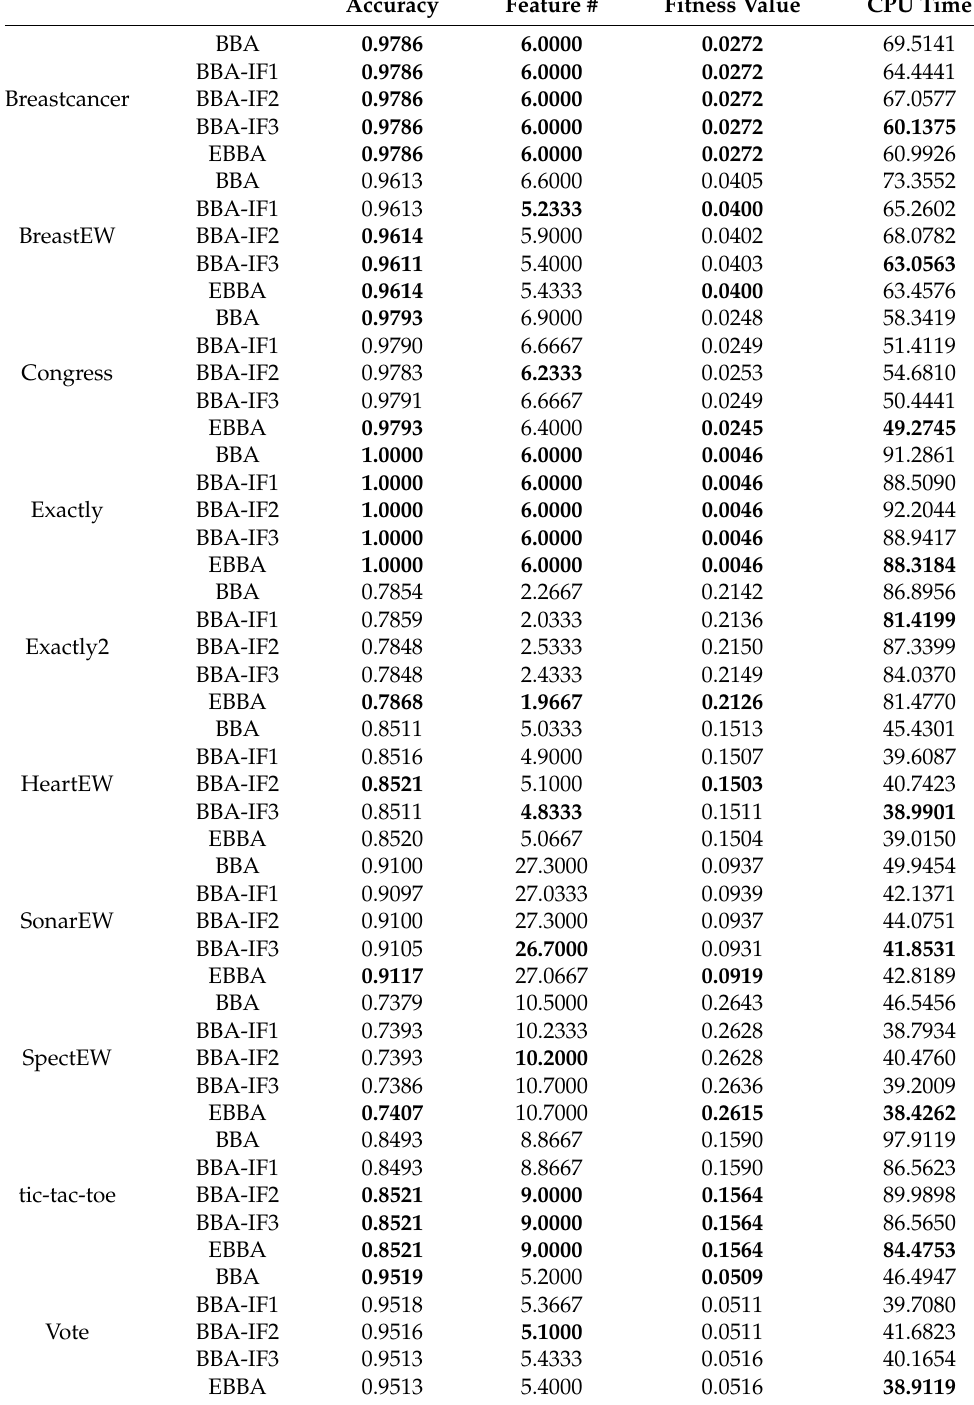
Table 4. Optimization results achieved by various EBBA versions. (The best values are highlighted in